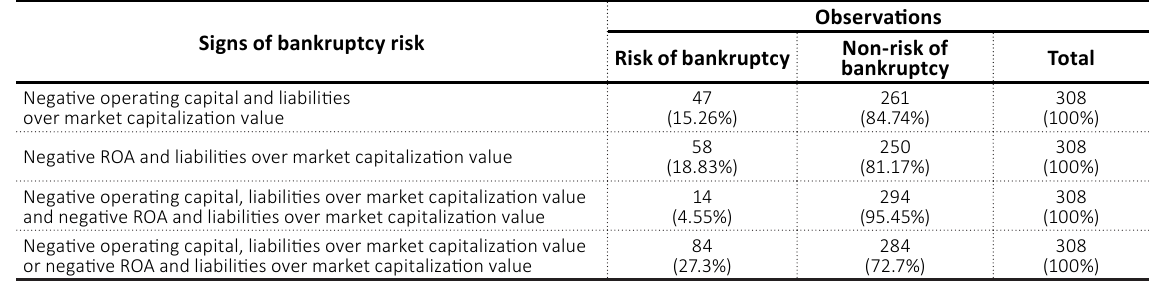
Table 1. Signs of bankruptcy risk